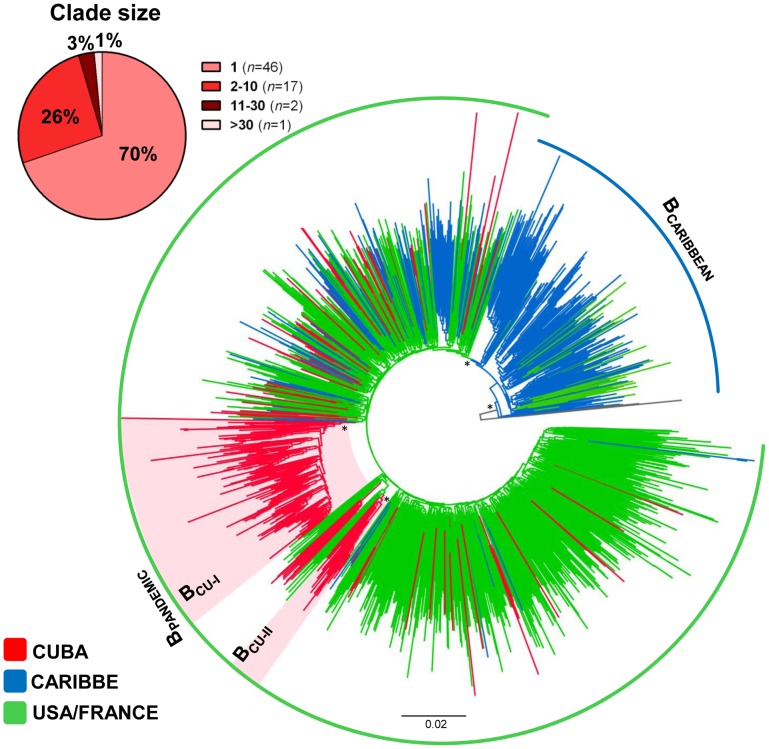
ML phylogenetic tree of HIV-1 subtype B pol (∼1000 pb) sequences circulating in Cuba (n = 322), US (n = 525), France (n = 348), and other Caribbean countries (n = 418).The branches are colored according to the origin of each sequence, as indicated at the legend (bottom left). The circular brackets highlight the position of the pandemic (BPANDEMIC, green line) and non-pandemic (BCARIBBEAN, blue line) HIV-1 subtype B clades. Shaded boxes highlight the position of the two major HIV-1 subtype B Cuban clades (BCU-I and BCU-II). The number of Cuban sequences distributed accordingly to the clade size is shown (top left). Key nodes with aLRT support values >0.80 (*) and ≥0.90 (**) are indicated. The tree was rooted using HIV-1 subtype D reference sequences (gray branches). The branch lengths are drawn to scale with the bar at the bottom indicating nucleotide substitutions per site.